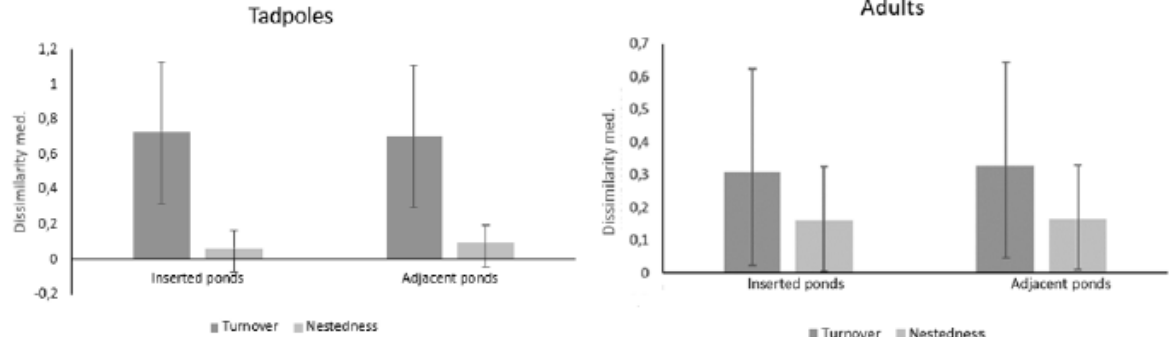
Figure 6. Mean dissimilarity values of species turnover (βsim) and nestedness (βnes) for tadpoles and adult anurans in ponds that are inserted in or adjacent to soybean